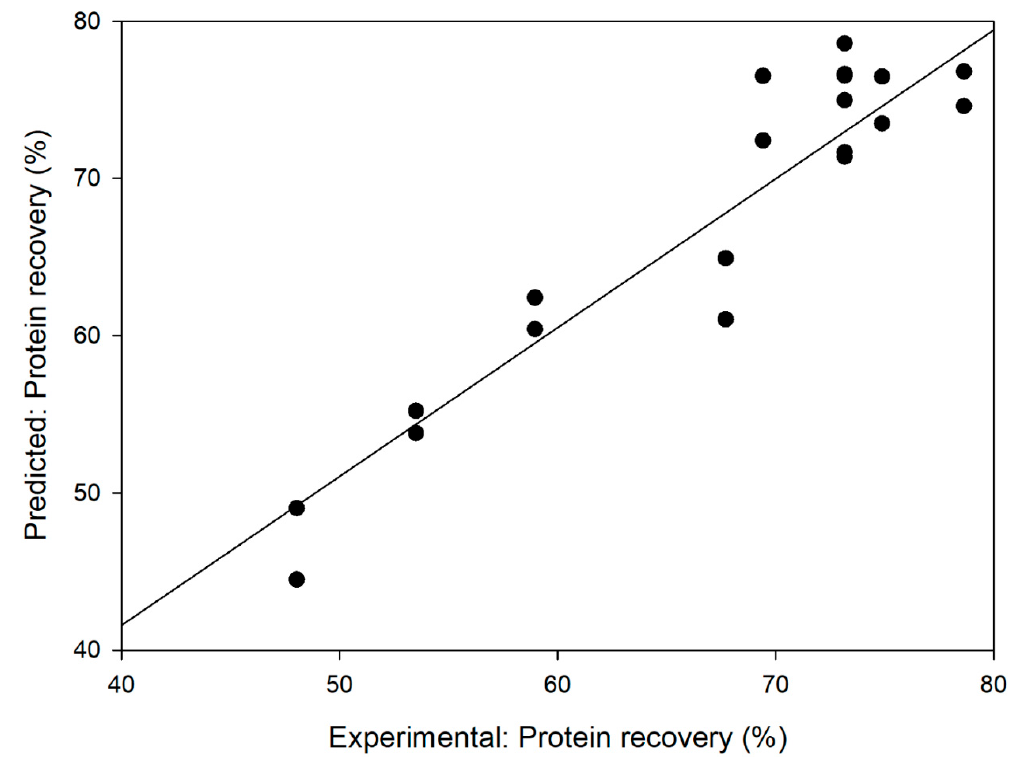
Figure 5. Scatter plot of predicted and experimental protein recovery.